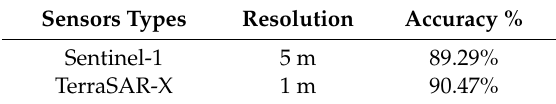
Figure 9. Precision recall curve for different image sizes using YOLOv2. Table 7. YOLOv2 performance with different